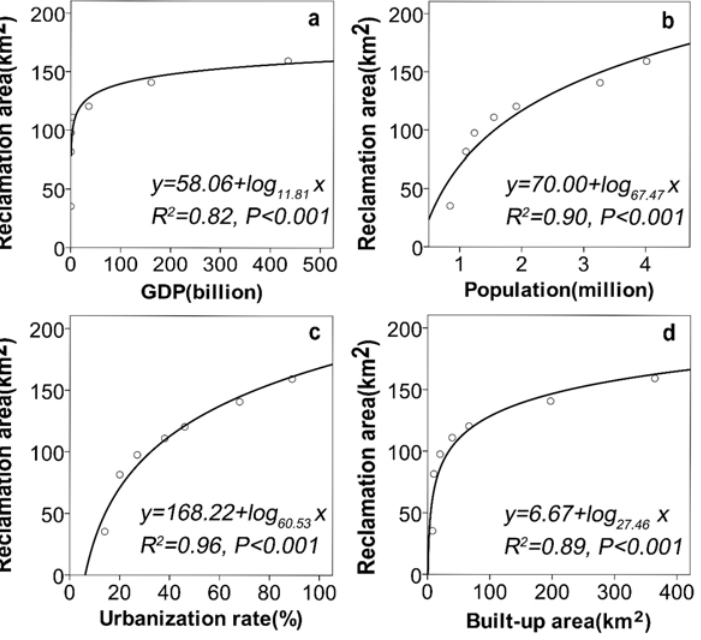
Figure 5. Relationships between land reclamation and ( a ) GDP, ( b ) population, ( c ) urbanization rate, and ( d ) urban built-up area.